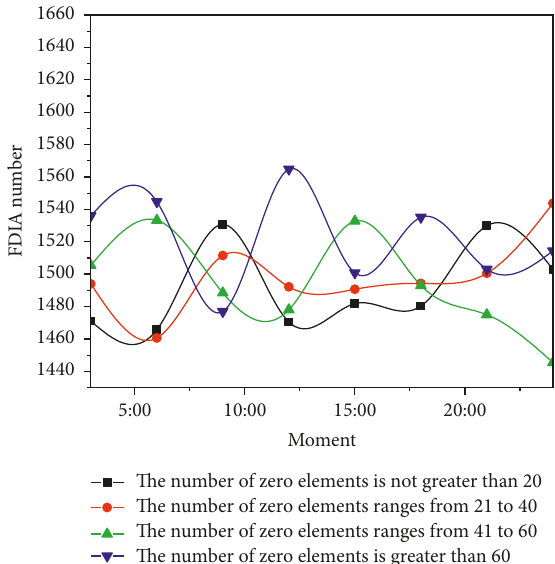
Figure 5: Distribution of zero elements of attack